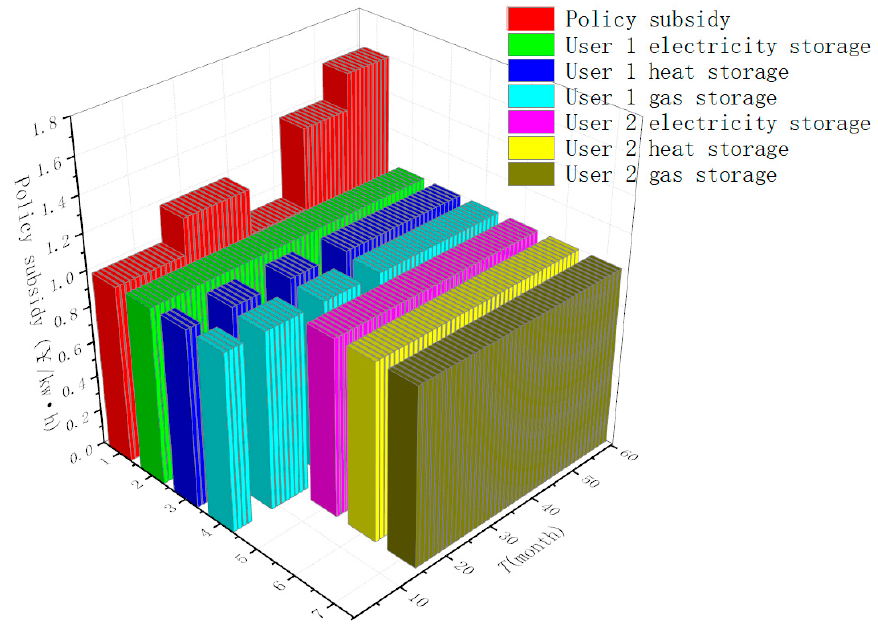
Figure 16. Long-term decision-making of energy storage users.